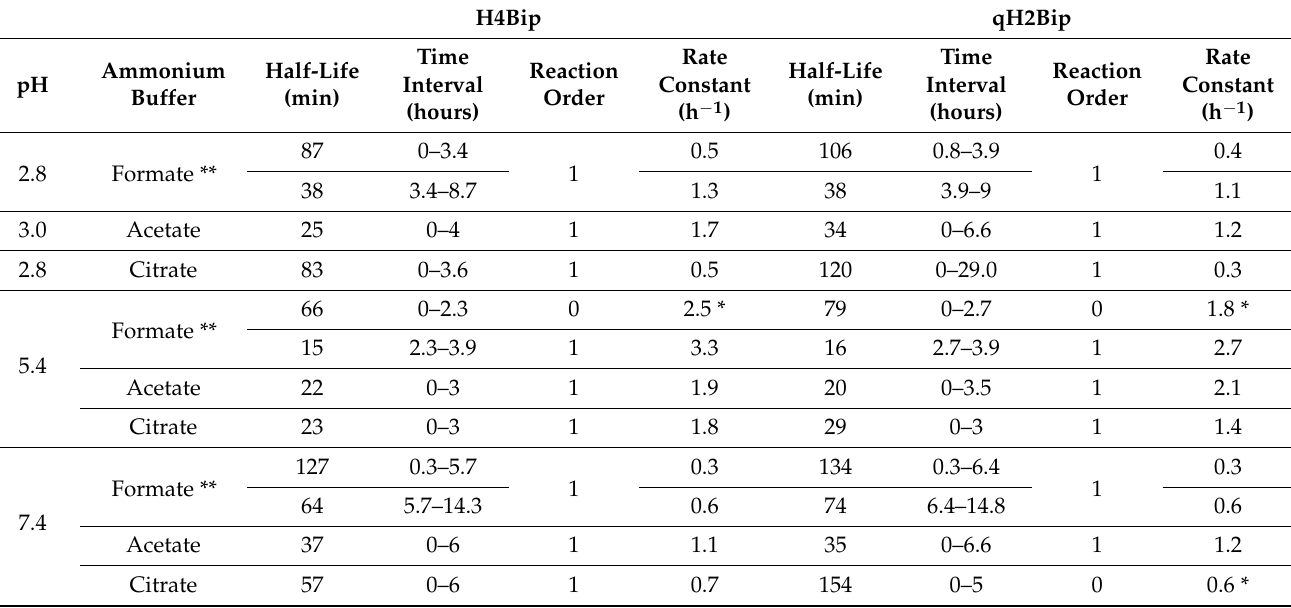
Table 3. H4B autoxidation kinetics parameters as a function of pH and type of buffer. H4Bip